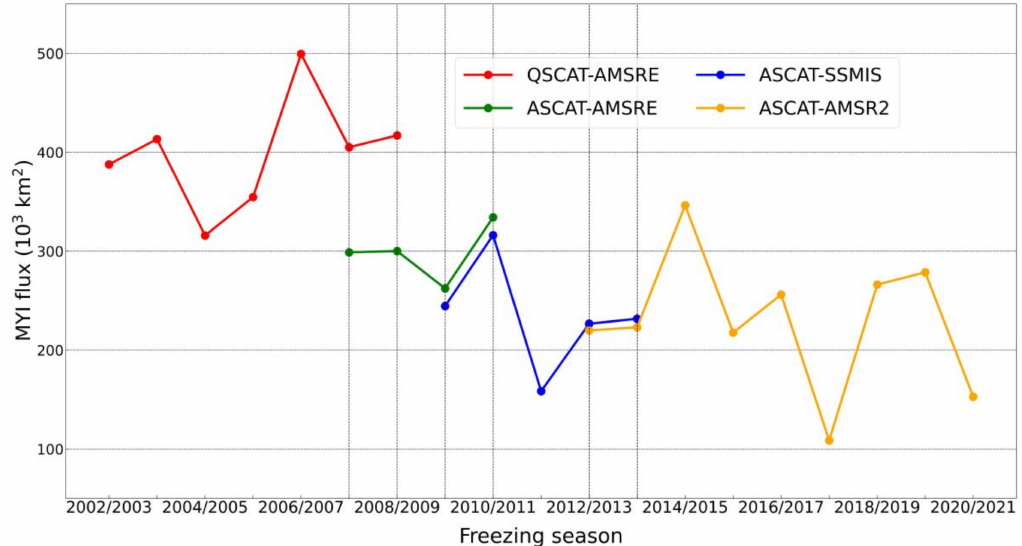
Figure 3. Wintertime Arctic MYI areal flux calculated from different data